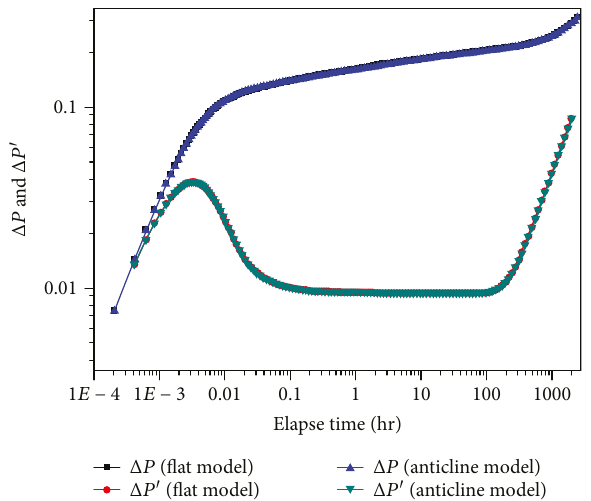
= 0 ) for anticline o